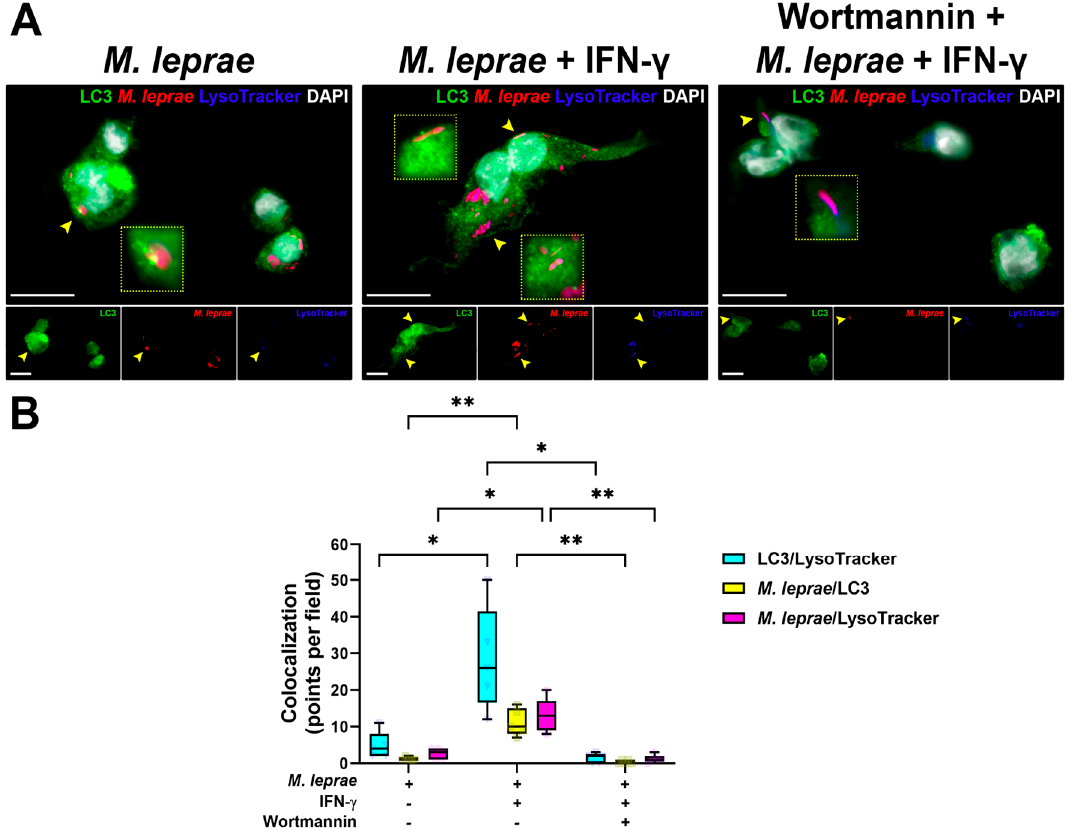
Figure 2. Wortmannin blockaded the autophagic flux induced by IFN- γ in THP-1 macrophages stimulated with M. leprae. ( A ) THP-1 macrophages were pretreated with 100 nM wortmannin for1 h, stimulated with M. leprae PKH26 (red) for 30 min (MOI 10:1), and treated with 10 ng/mL IFN- γ for 18 h. LC3 expression was assessed by immunofluorescence using an anti-LC3 antibody (green), with the nucleus stained with DAPI (white). LysoTracker (blue) was added to the cultures 30 min before fixation. Arrowheads indicate colocalization profiles in at least two channels, which are shown on the insets. Scale bar: 20 μ m. ( B ) Colocalization analysis. The images represent five experiments. Data in whiskers are the minimum to maximum with all points shown; * p < 0.05, ** p < 0.01 by the repeated measures two-way ANOVA with the Geisser-Greenhouse correction and Tukey’s multiple comparisons